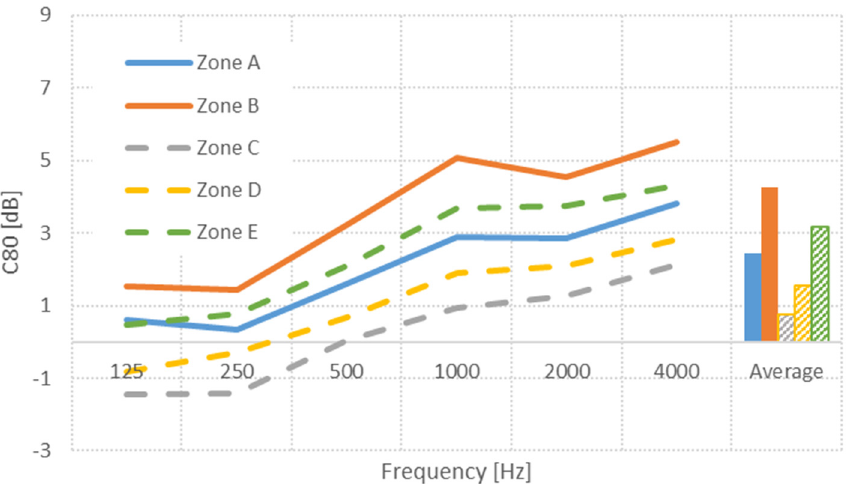
Figure 17. Clarity (C80) obtained in the auditorium, when the variable acoustic solution provides minimum absorption (configuration R), by